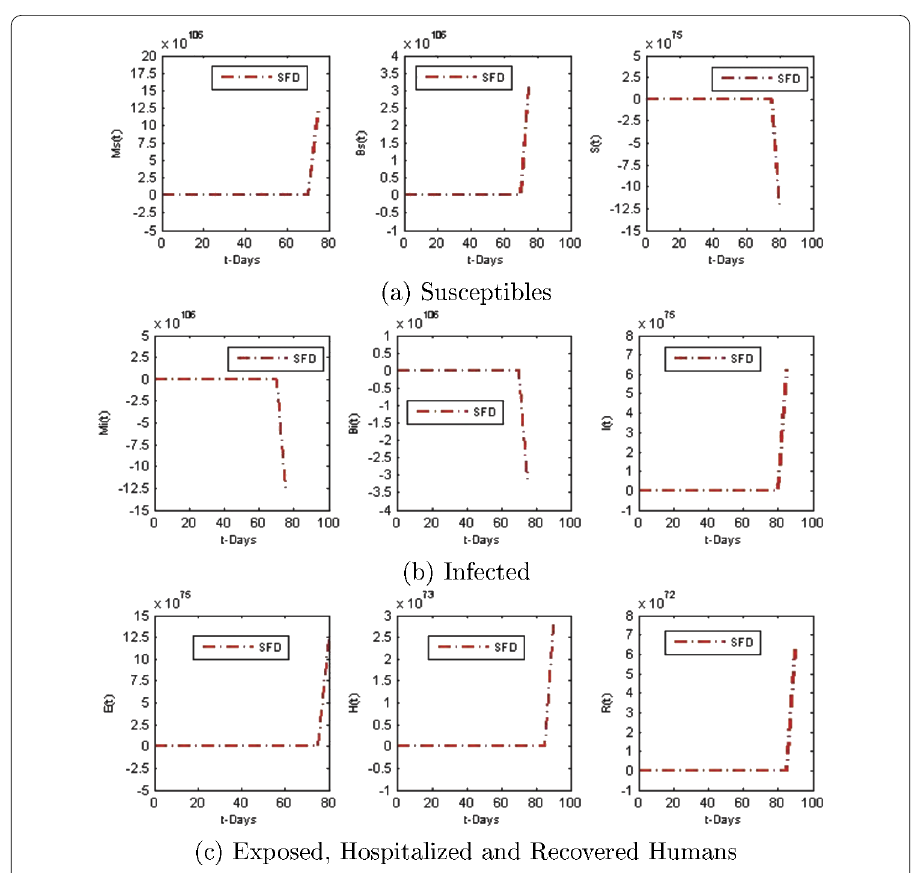
Figure 2 The approximate solutions of the fractional delay optimal control problem by using SFDM. When 0 ≤ u 1 ≤ 0.8, 0 ≤ u 2 ≤ 0.5, with d = 10 and α = 1, and (cid:7) t =